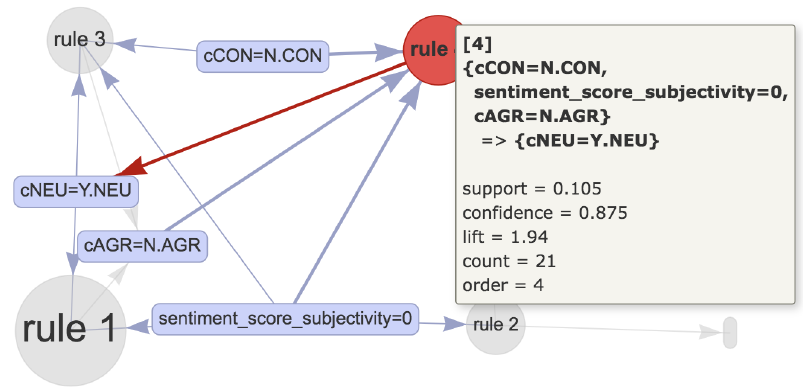
Figure 6. Case study of association rule based on selected